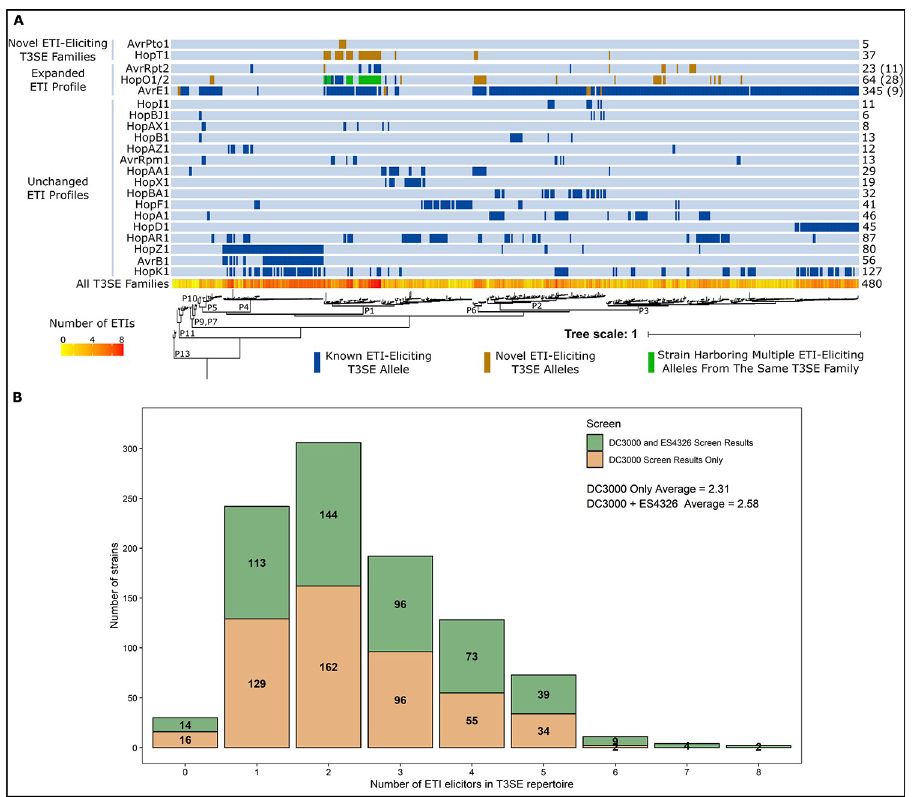
Fig 3. The A . thaliana ETI load of P . syringae . (A) Predicted orthologs of ETI elicitors carried by each of the 494 P . syringae strains used to generate the PsyTEC collection mapped onto a previously generated P . syringae core genome phylogeny with phylogroup designations indicated by P1-P13 [9,47].Putatively ETI-eliciting homologs are color coded as follows: blue—previously elucidated ETI-eliciting homolog; orange—newly identified putatively ETI-eliciting homologs originating from the PmaES4326 PsyTEC screen; and green—strain harboring previously and newly identified putatively ETI-eliciting homologs from the same T3SE family. Numbers on the right indicate the total number of strains that harbor putatively ETI-eliciting alleles from each T3SE family. For T3SE families with expanded ETI profiles, the number in parenthesis indicates the number of new strains harboring putatively ETI-eliciting T3SE alleles within that T3SE family. The total number of ETI-eliciting T3SE alleles carried by each strain is also mapped onto the phylogeny, ranging from 0 (yellow) to 8 (red). (B) Distribution of the number of putative ETI-eliciting T3SE alleles carried by each of the 494 P . syringae strains included in this study when using results from only the PtoDC3000 screen or from both the PtoDC300 and PmaES4326 screens